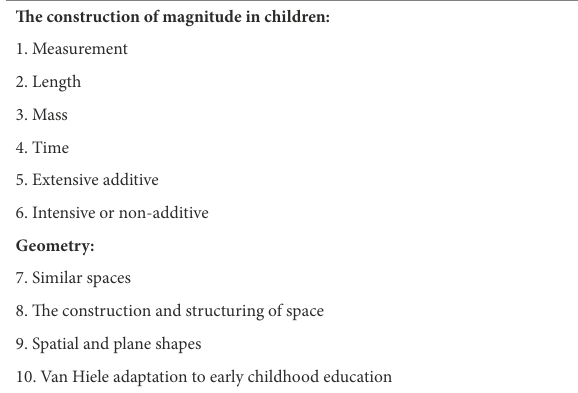
TABLE 1 Distribution of the blocks in the subject Development of Logical-Mathematical Thinking and its Didactics II. Blocks